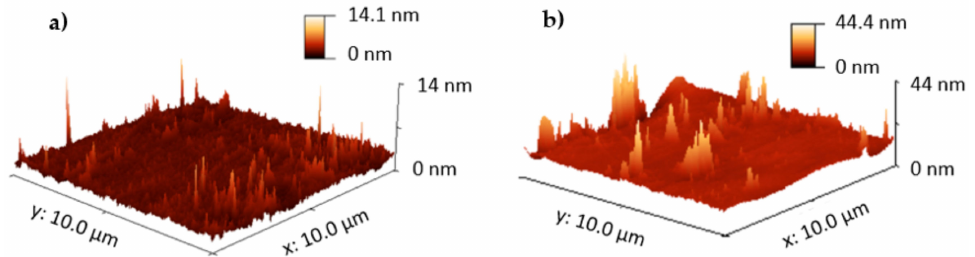
Figure 4. Representative AFM morphology of the ( a ) the non-functionalized (intrinsic graphene) surface, and ( b ) the functionalized graphene surface with